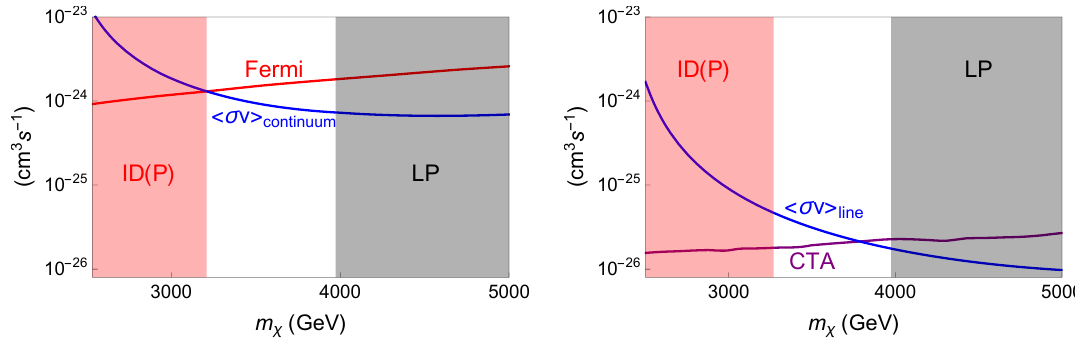
Figure 8 . The annihilation cross section producing the continuum gamma-ray signal and that producing the line gamma-ray signal are depicted by a blue line in left and right panels, respectively, as a function of the dark matter mass. The cross sections are compared with the present constraint from the Fermi-LAT experiment (red line) and the expected sensitivity of the CTA experiment (purple line), where the region above the lines are excluded/covered by the experiments. Here, the coupling λ χH is fixed at each dark matter mass m χ so that it gives the thermal relic abundance which coincides with the dark matter density observed today. Shaded region below ∼ 3 TeV is forbidden because of the present constraint by the Fermi-LAT experiment, while that above ∼ 4 TeV is not preferred when we postulate that the dark matter theory does not break down up to high enough energy